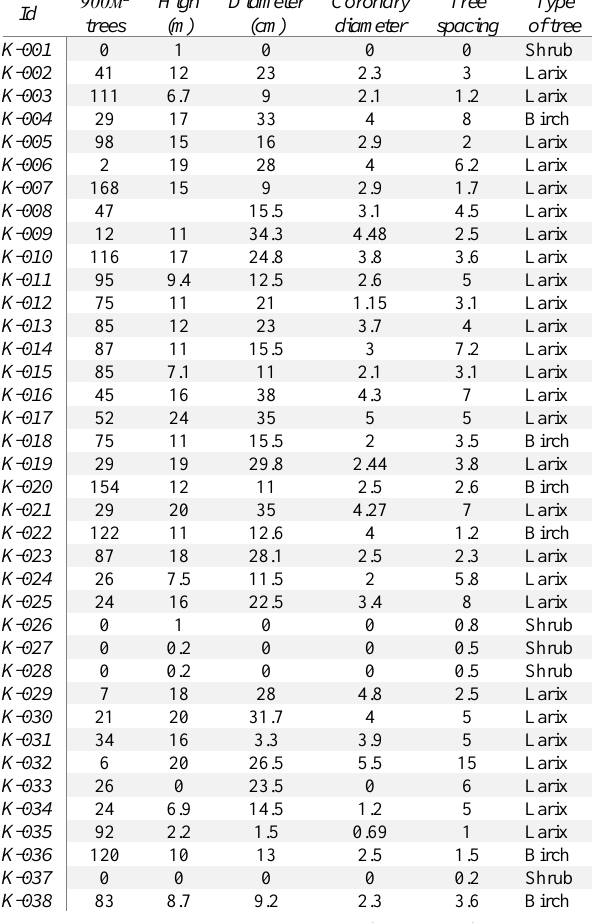
Table 1. Field measure data (2016-2019)